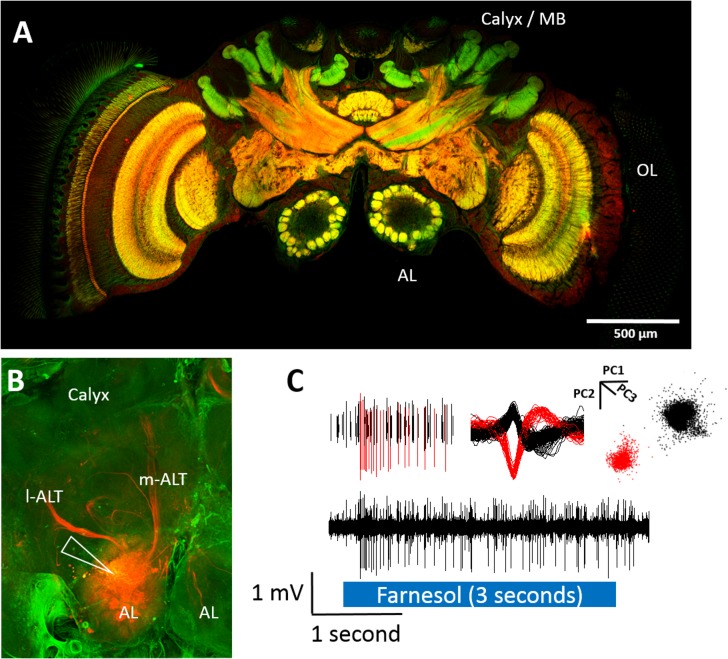
Extracellular recordings of antennal lobe (AL) activity in bumble bees (Bombus terrestris).(A) Overview of the brain of a Bombus terrestris worker (AL = antennal lobe, OL = optical lobe, MB = mushroom body), immunostained with anti-synapsin (red) and fluorophore conjugated phalloidin (green). (B) After recording we used a standard dual staining technique resulting in yellow fluorescence tissue around the electrode’s tip (white arrow) to verify the position in the AL. In addition, the lateral (l-) and the medial (m-) antennal lobe tract (ALT) was labelled (for details see Brill et al. (49)). (C) Example of a response to farnesol (blue bar). The signal to noise ratio of the extracellularly recorded activity (black trace) allows a clear separation of single unit activity. The upper panel illustrates the waveform overdraw of two units (black and red) and the unit separation after principal component analysis. The first three principal components (PC1-3) of the whole recording trace (150 seconds) were plotted against each other. Each dot refers to one action potential.